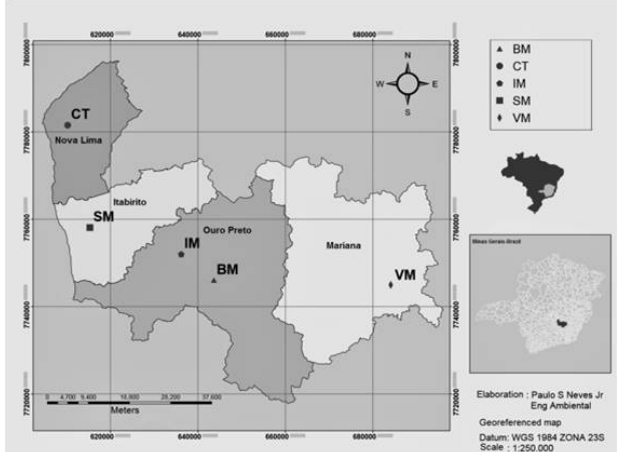
Fig 1 . Sampling areas of the Iron Quadrangle, Minas Gerais, Brazil. BM (Bemil), CT (Control area), IM (Irmãos Machado), SM(SAFM), VM (Viamar).